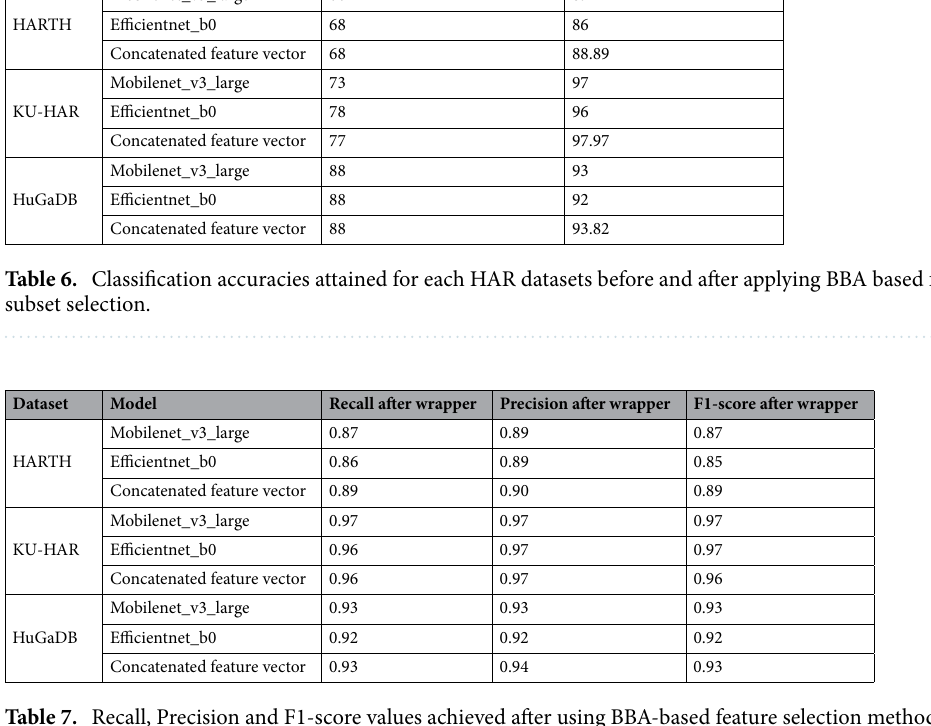
Table 7. Recall, Precision and F1-score values achieved after using BBA-based feature selection method for three HAR datasets.